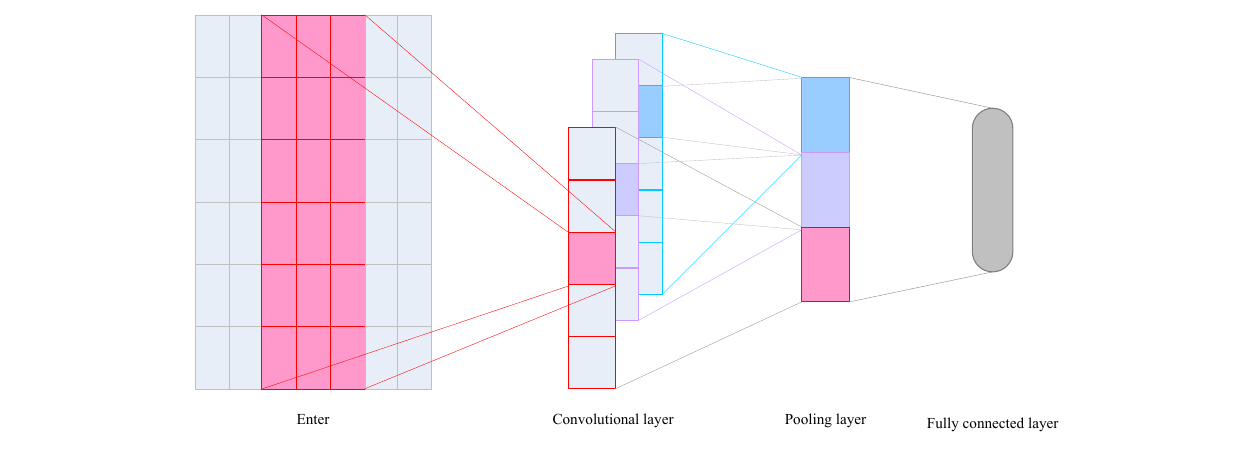
FIGURE 5 | Convolutional neural network (CNN) basic network structure diagram.